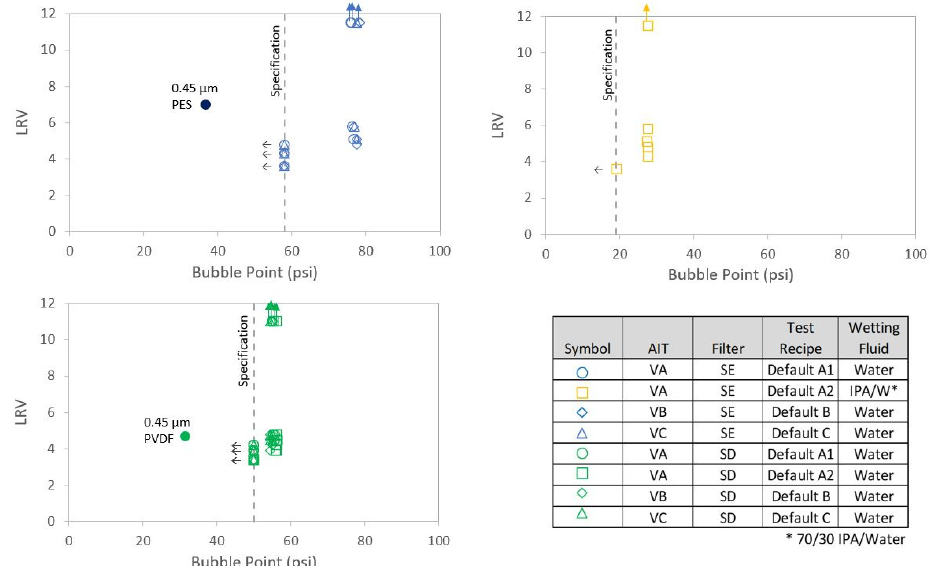
Figure 11. Relationship between reported bubble point and LRV. Upward-pointing arrows indicate no bacteria detected in the filtrate. Leftward-pointing arrows indicate that the AIT either reported a gross leak or invalid result, not a quantified bubble point below the filter specification.